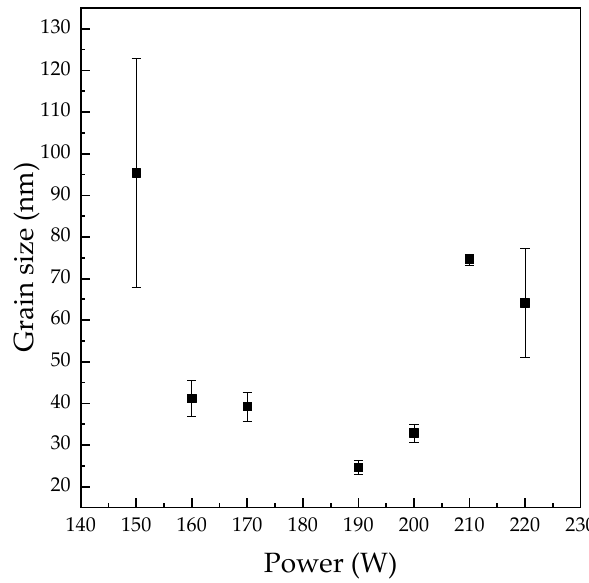
Figure 8. Grain size for different deposition source powers.